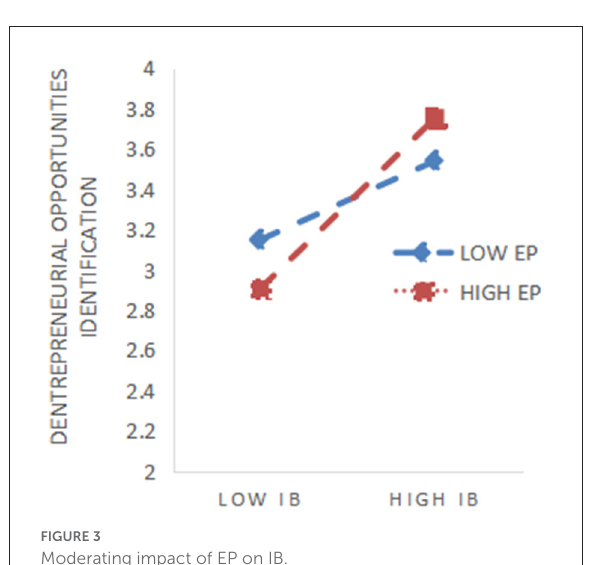
FIGURE3 Moderating impact of EP on